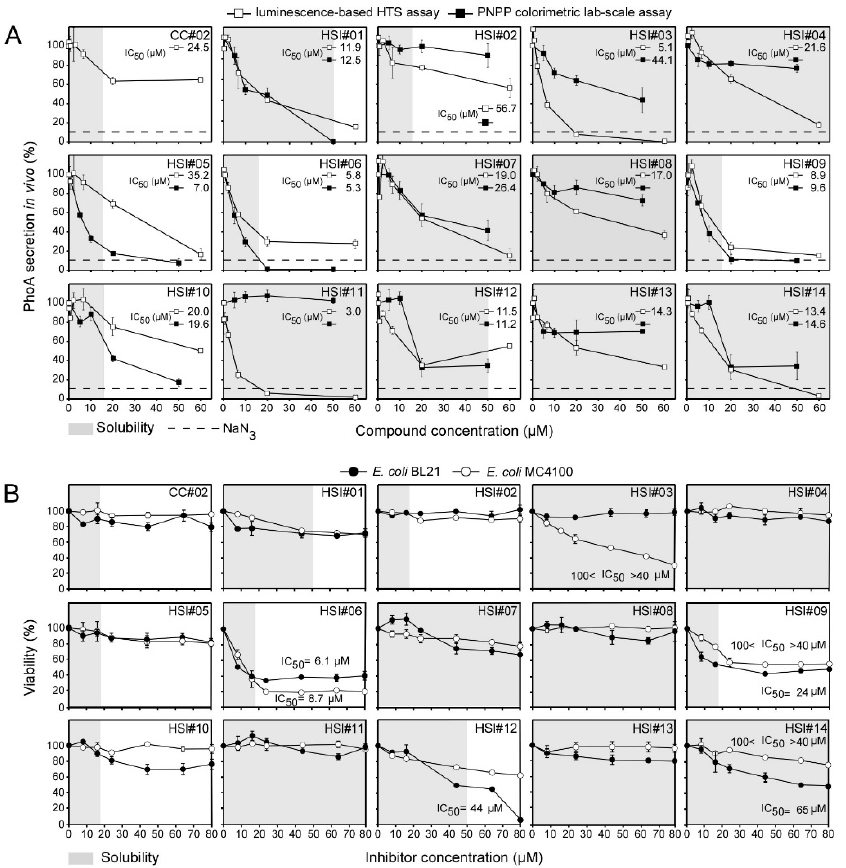
Figure 2. In vivo anti-PhoA secretion and antibacterial activity of secretion inhibitors toward E. coli strains. ( A ). The effect of the 14 compounds discovered by HTS and CC#02 at different concentrations on PhoA secretion in vivo tested using the luminescence (HTS) and the p -nitrophenyl (lab-based) PhoA actvity assays. PhoA secretion in the absence of any compound but in the presence of DMSO 2.5% (v/v) was set as 100%. ( B ). Inhibition of bacterial viability by the indicated inhibitors and CC#02. The growth of the indicated E. coli strains was measured at OD 600 (OD 600 in the absence of any compound but in the presence of 2.5% (v/v) dimethyl sulfoxide was taken as 100% and OD 600 in the presence of inhibitor was normalized to it) was plotted against the inhibitor concentration. IC 50 values for growth inhibition are indicated. n = 3. The results are presented as the mean ± SD. Gray shade: aqueous